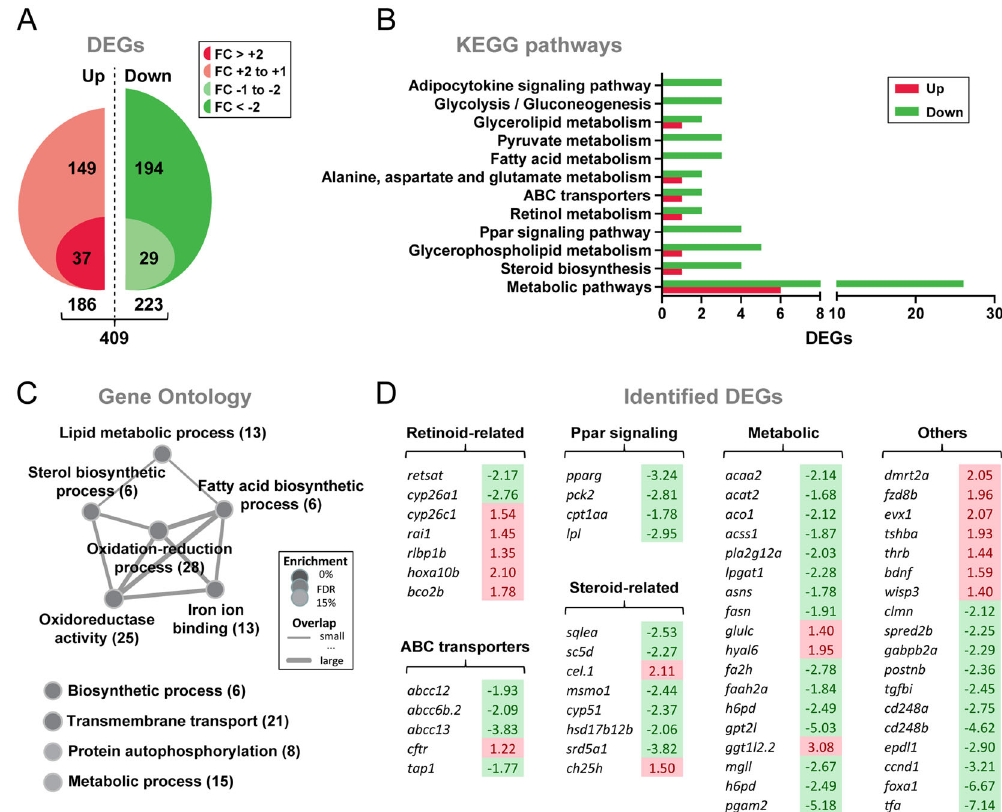
Fig. 4 Gene expression pro fi ling of testis tissue in response to Insl3. A Total numbers of up-regulated and down-regulated genes (DEGs) identi fi ed by RNAseq ( N = 3; p < 0.05). To generate testis samples for RNAseq, male zebra fi sh testes were incubated in the absence or presence of zebra fi sh Insl3 (100 ng/mL) for 2 days. FC fold change. B , C Insl3-regulated KEGG pathways ( B ) and Gene Ontology terms ( C ) in adult zebra fi sh testis tissue. KEGG pathways represented by at least three DEGs and ratio of regulated genes (down-regulated/up-regulated) higher than 2 were considered for the analysis. In C , number of identi fi ed genes is shown in brackets and enrichment signi fi cance (FDR, false discovery rate) is represented as a color gradient. D Selected DEGs identi fi ed by KEGG and GO analyses grouped by their function. Fold change values are shown with a red or green background indicating up-regulation or down-regulation, zebra fi sh 25 , we decided to investigate a possible link between Insl3 and RA signaling. Moreover, we were intrigued by the consistent modulation of Pparg expression.